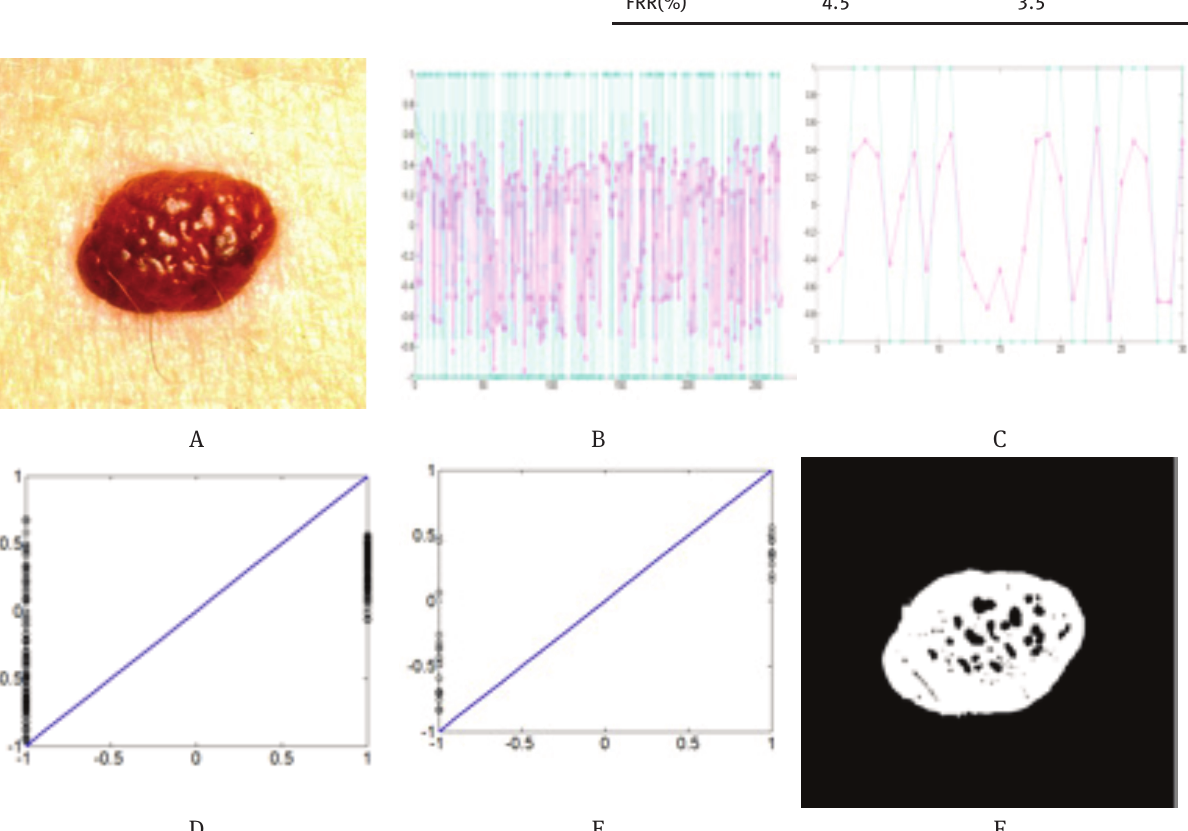
Figure 4: (A) input image, (B) and (C) train and test approximation resemblance (red: original and blue: approximation) respectively, (D) and (E) classified train and test data, (F) output melanoma segmented image